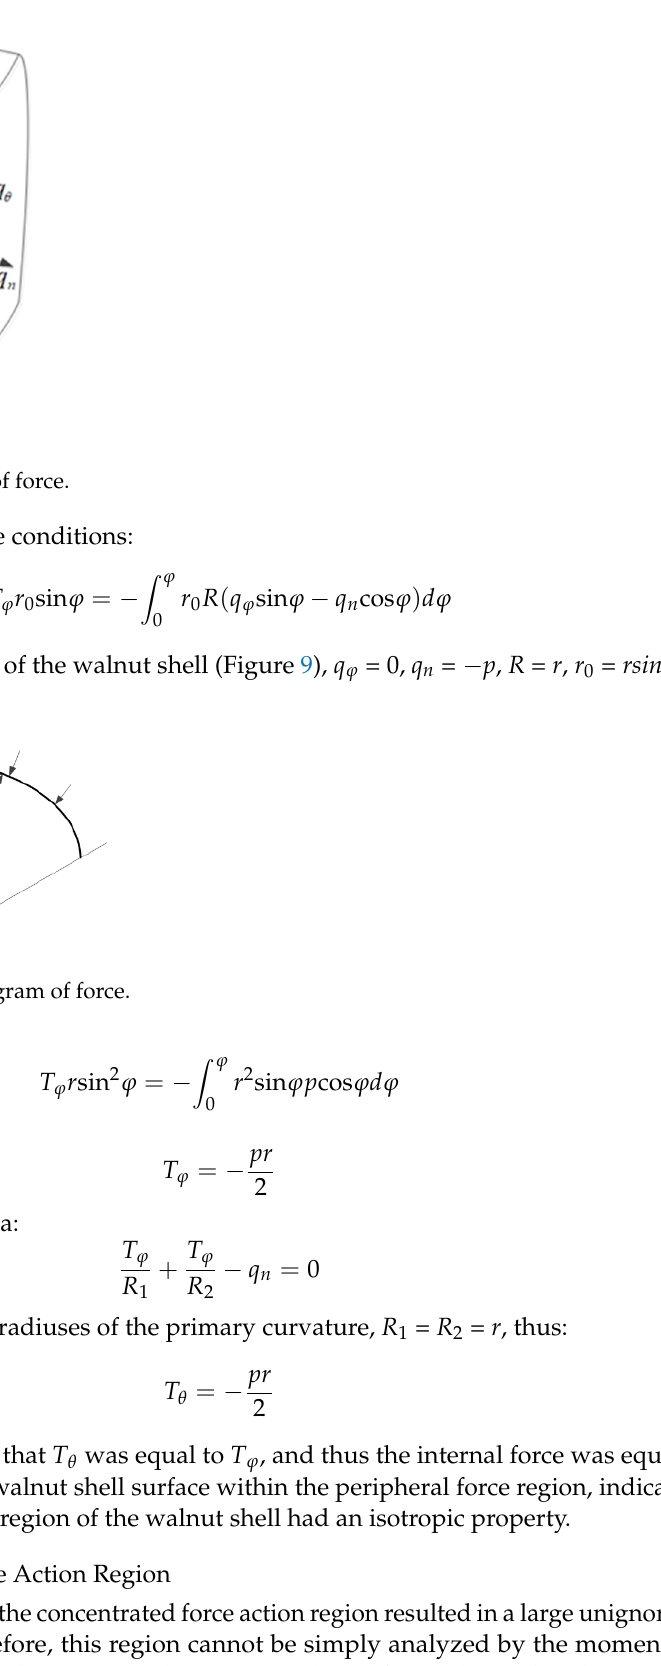
Figure 10. Walnut 3D scanned model.